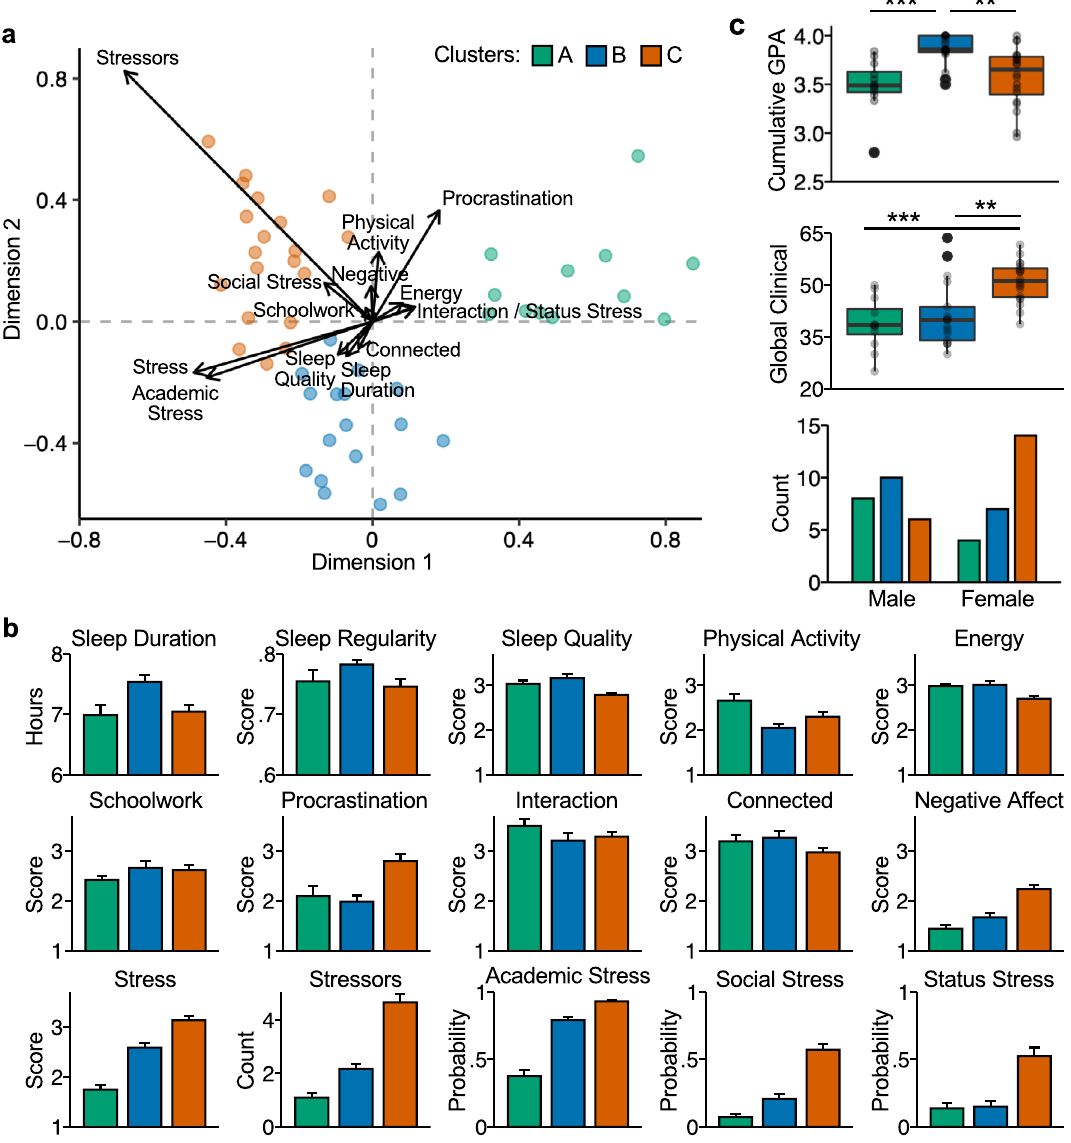
Figure 5. Clustering analysis reveals three distinct student profiles. ( a ) Biplot shows both the maximal separation among the clusters, displayed as dots colored by cluster, and the original variables used in the analysis, shown as standardized basis vectors on the two dimensions. The length of the vectors represents standardized regression coefficients. The arrows for Interaction and Status Stress are almost fully overlapping, and the vector for Sleep Regularity is almost exactly at (0, 0). ( b ) Bar plots show between-person means of each clustering variable separately by cluster. Error bars represent standard errors of the mean. ( c ) Boxplots show participants’ cumulative grade point average (GPA) their first year of university (top) and mean Global Clinical symptom severity (middle). Asterisks represent statistically significant differences between cluster pairs (two-tailed t -tests; **p < 0.01, ***p < 0.001). Bottom bar plot shows the self-reported sex breakdown of the three emerged is that the three subgroup clusters continued to have distinct patterns of distress, with Social Stress, but not Academic Stress, indicative of those individuals with severe distress (Fig. 7). Cluster C, which had originally shown the highest overall distress, again stood out with elevated Global Clinical Scores during the COVID-19 pandemic (Fig. 7a; ANOVA p < 0.05; post hoc t- test of Cluster C vs. Clus- ter A, p < 0.05; post hoc t- test of Cluster C vs. Cluster B, p = 0.06) and higher Perceived Stress and Anxiety and Depression symptoms (ANOVAs ps < 0.01; post hoc t- tests of Cluster C vs. Cluster A and Cluster C vs. Cluster B, p s < 0.05). By contrast, Clusters A and B both reported low Perceived Stress and clinical symptoms (post hoc t- tests of Cluster A vs. Cluster B, p s > 0.11). Moreover, while at the beginning of the pandemic all three clusters